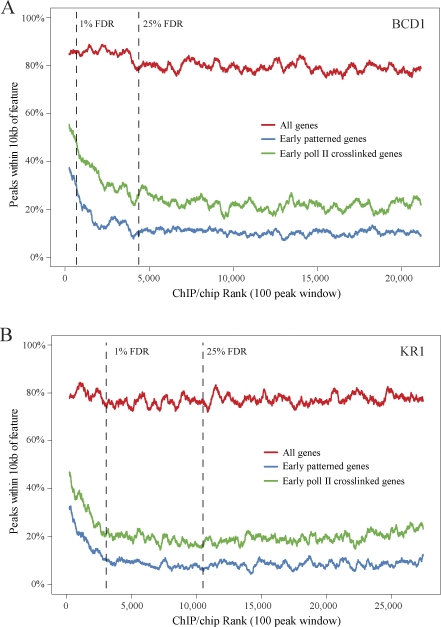
Highly Bound Regions Are Associated with Genes Transcribed and Patterned in the BlastodermAnalyzed are the percentage of primary peaks that are within 10 kb of the 5' end of a gene. Genes are divided into three categories, all genes (from genome release 4.3, March 2006), genes with known patterned expression (hand annotated based on Berkeley Drosophila Genome Project [BDGP] in situ images [35]) and transcribed genes (defined by our RNA Polymerase II ChIP/chip binding, see Materials and Methods). Percentages are calculated in nonoverlapping windows of 100 peaks down the rank list to the 80% FDR threshold. The position of the 1% and 25% FDR cutoffs are indicated with vertical dotted lines. (A) shows the results for the BCD1 antisera and (B) the results for the KR1 antisera.